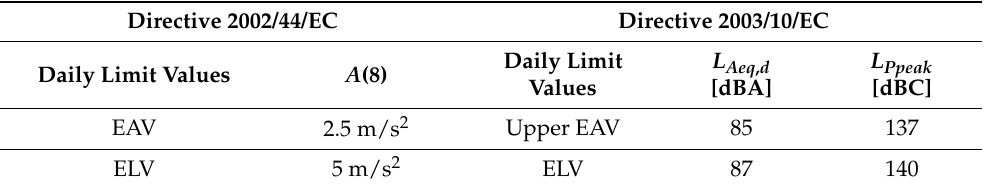
Table 1. The daily limit values EAV and ELV defined by Directive 2002/44/EC [68] and Directive 2003/10/EC